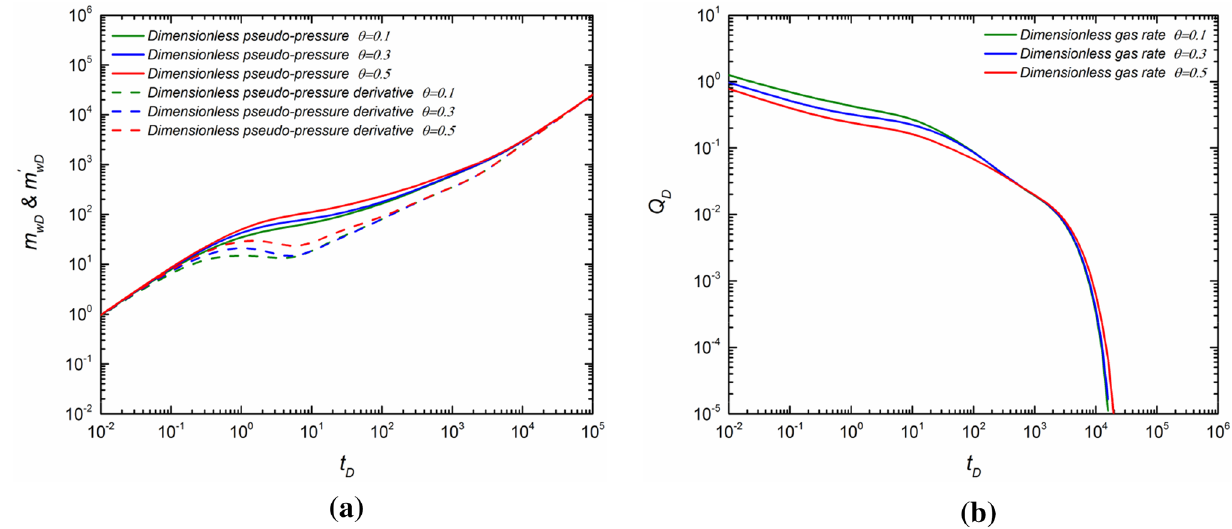
Fig. 9 Effect of conductivity index on pseudo-pressure and rate curves. a Dimensionless pseudo-pressure and pseudo-pressure derivative curve, b dimensionless rate curve